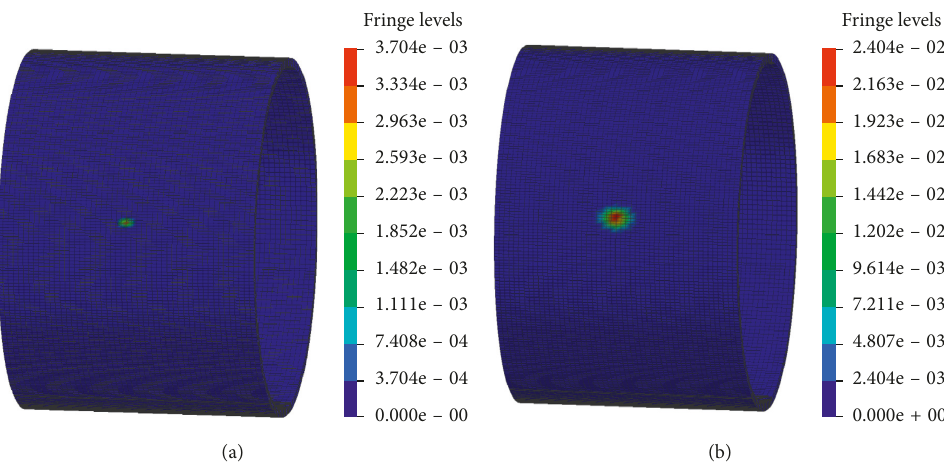
Figure 23: Strain nephograms of impact A within 10m. (a) 0.55s nephogram. (b) 0.66s nephogram.